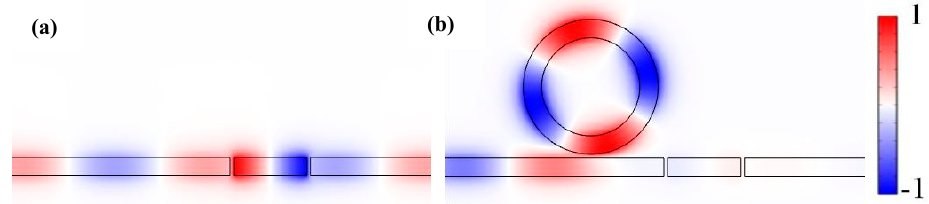
Figure 3. Contrast diagram of the normalized magnetic field distribution of the MIM waveguide at λ = 710 nm ( a ) with the ring cavity and; ( b ) without the ring cavity.